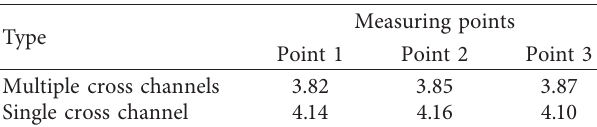
Figure 14: Smoke diffusion at 300s with three open cross channels. Table 5: Comparison of flow velocity (ms − 1 ) in the most dangerous cross